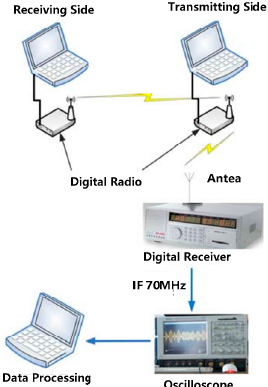
Figure 6. Scheme of the data acquisition system.